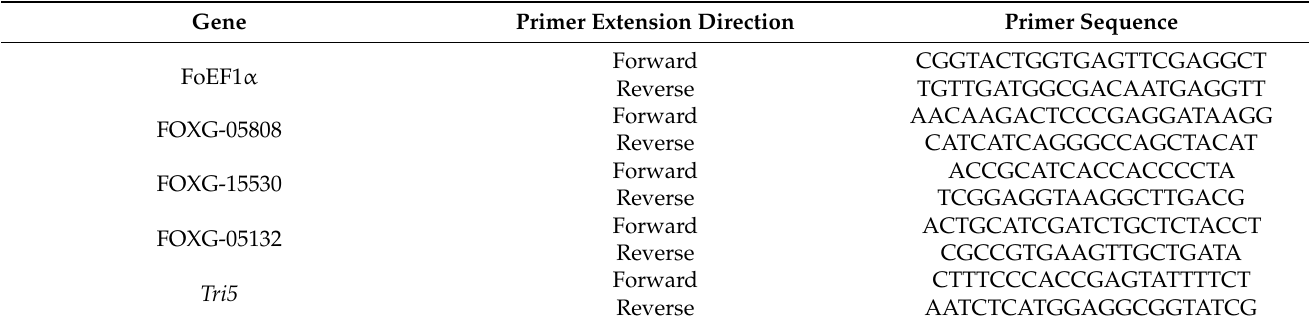
Table 1. A sequence of gene primers for